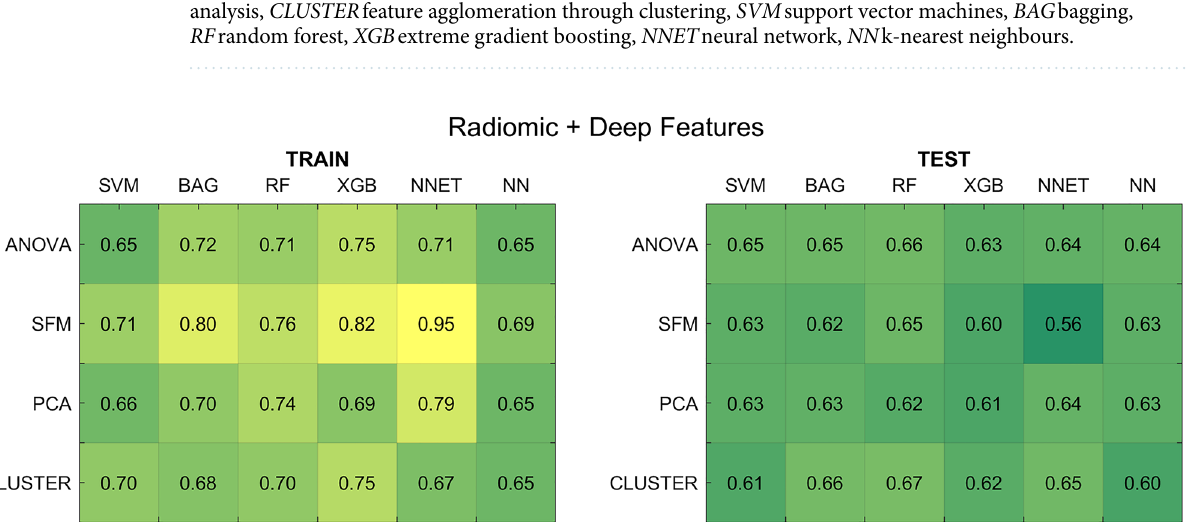
Figure 5. Results for the deep feature-based models without clinical data. (Left panel) Average AUCs on the five training splits. (Right panel) Average AUCs on the test splits. SFM SelectFromModel, PCA principal component